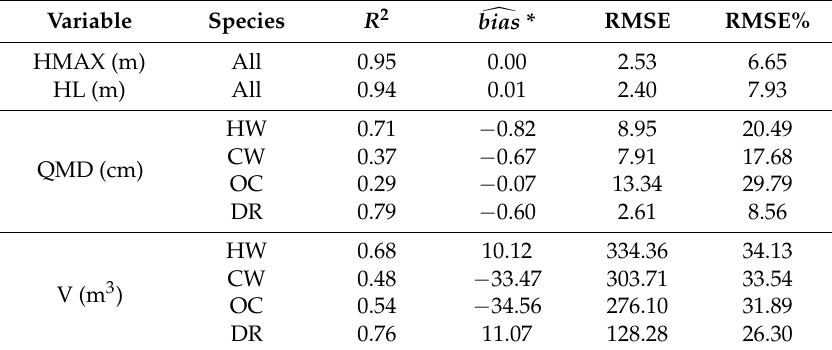
Table 3. Enhanced forest inventory (EFI) modelling